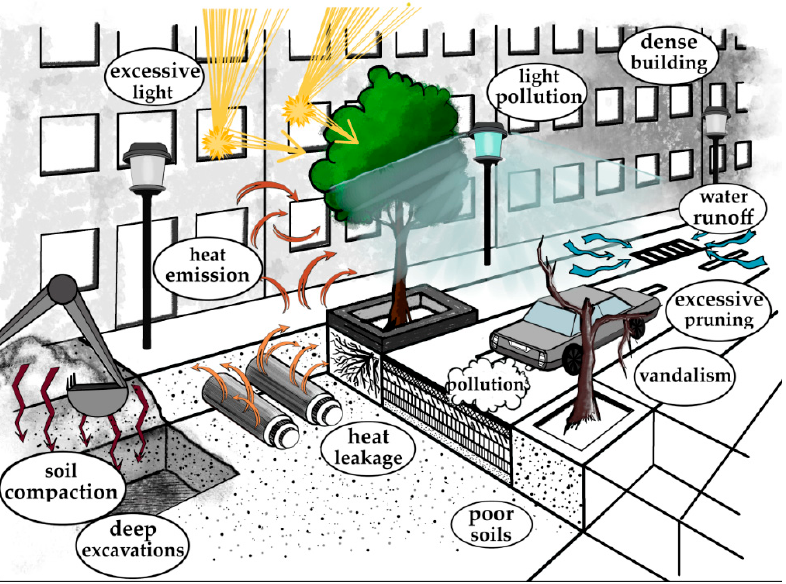
Figure 3. Most common stress factors for urban street trees induced by anthropogenic activity.